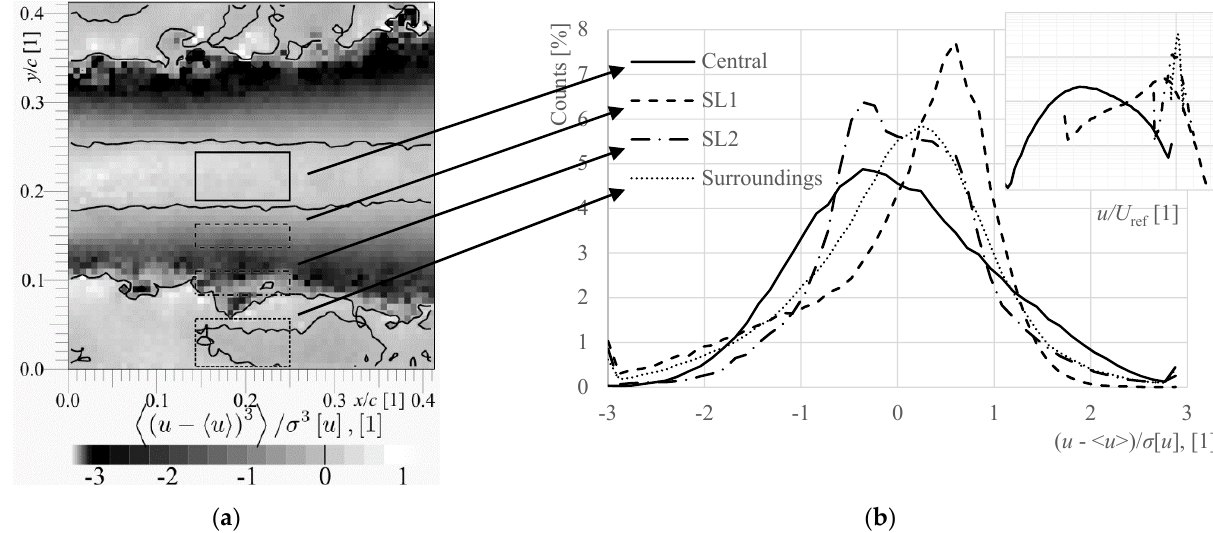
Figure 11. ( a ) Spatial map of the skewness of stream-wise velocity component. ( b ) Probability density function (PDF) of the instantaneous stream-wise velocities within the four denoted rectangles, solid line in the wake central region, dashed line in the inner shear layer (SL), dash-dotted line in the outer shear layer and the short, dashed line in the surrounding region. The u values are normalized by the local average and standard deviation. The inset shows the PDF as the function of velocity and it shows different widths and positions of the distributions (note the logarithmic scale in inset).